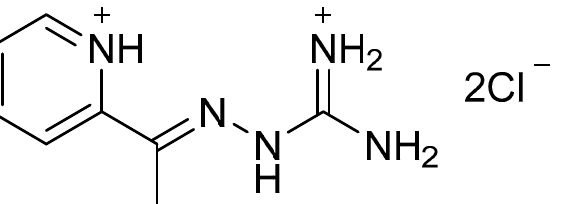
Figure 1. Structural formula of the chloride salt of the 2-acetylpyridine and aminoguanidine Schiff base, [H 2 L]Cl 2. base, [H 2 L]Cl 2